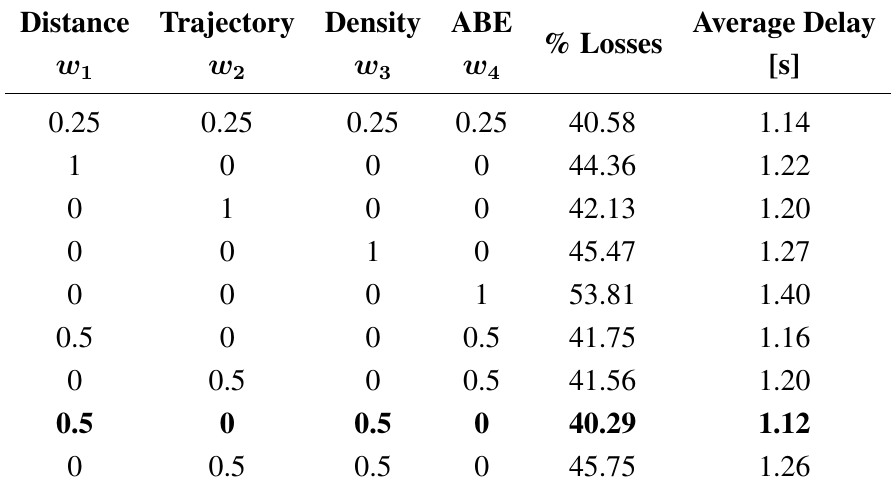
Table 6. A summary of the results of the evaluation of some combination of the weights for each metric (in a medium density